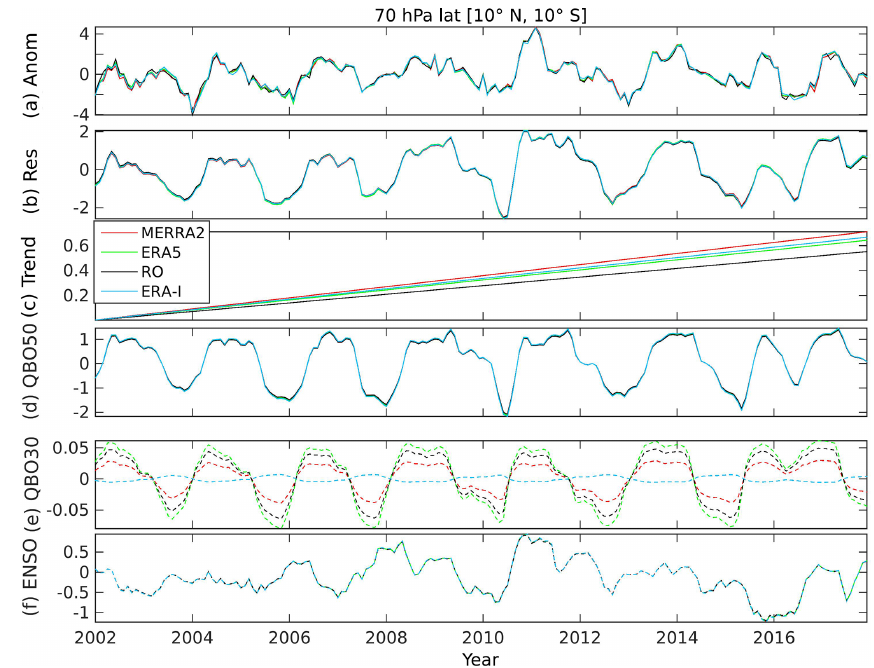
Figure 7. As in Fig. 6 but for